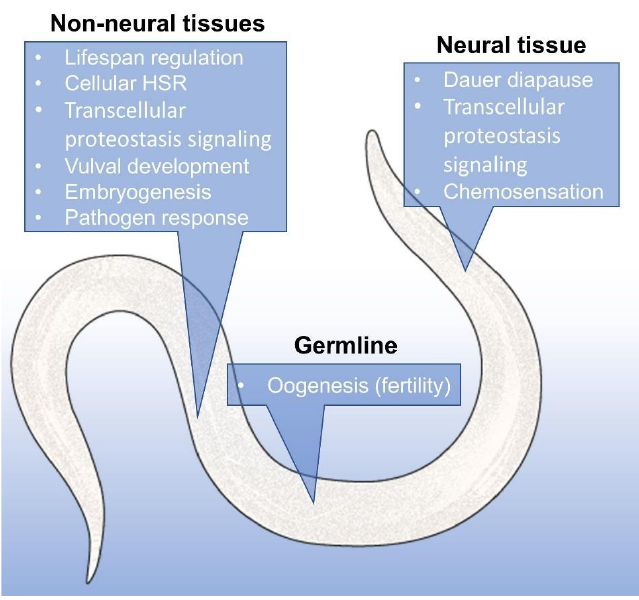
Cells 2022 , 11 , x FOR PEER REVIEW Figure 4. Hsp90-dependent organismal processes that involve proteostasis in C. elegans .